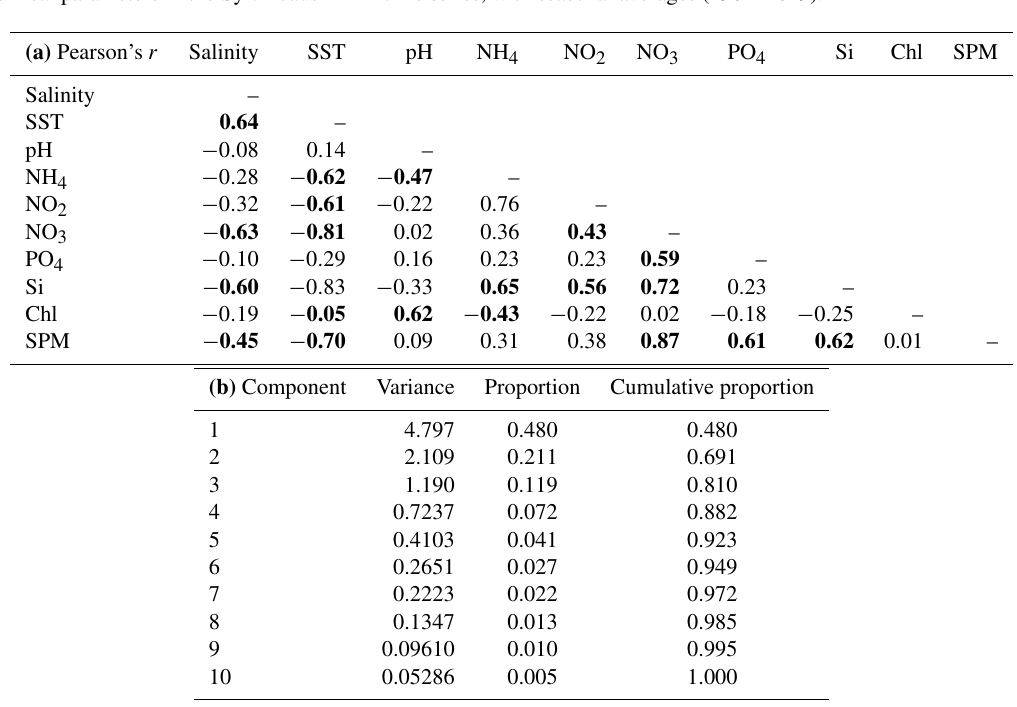
Figure 2. Seasonal sampling efforts summarized for all Sylt Roads stations in the SRB (1973–2019). The inserts compare the seasonal efforts from the early days (1973/1974–1998) with the most recent part (1999–2019) of the time series. Table 4. Pearson’s r values (a) from a correlation analysis of Sylt Roads LTER physical and hydrochemical parameters based on seasonal averages (1984–2019). Values > 0 . 4 and < − 0 . 4 are in bold. (b) Variance and (cumulative) proportion of principal components. Physical and hydrochemical parameters in the Sylt Roads LTER time series, with seasonal averages